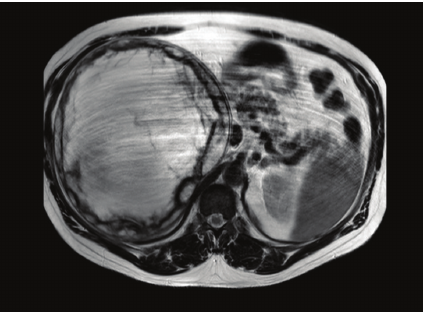
Figure 3: Patient’s MRI T2-weighted image with heterogeneously low signals.